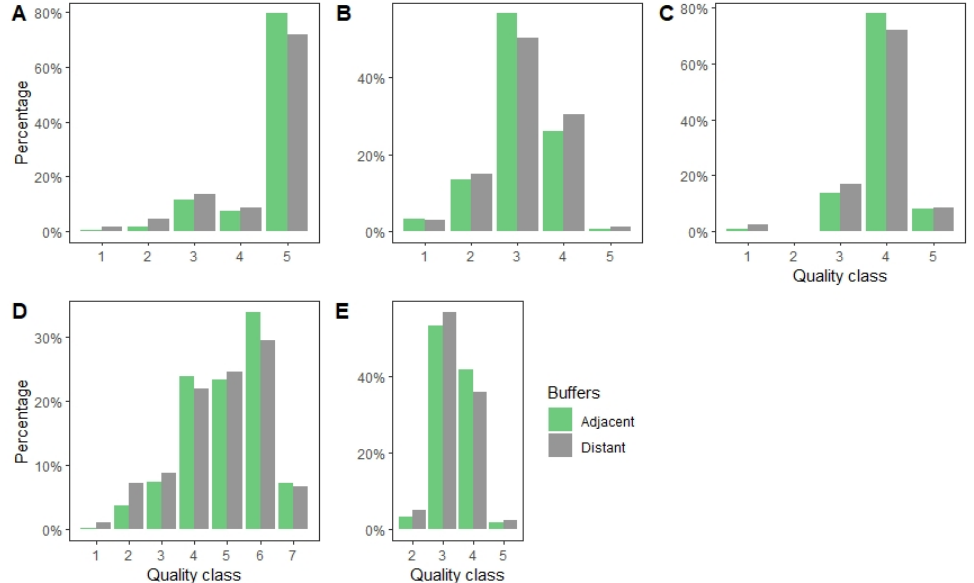
Figure 4. Percentage (%) of forest stands in adjacent (0–50 m) and distant (51–200 m) riparian buffers strips by indicator quality class. ( A ) is the indicator Potential for the presence of medicinal plants; ( B ) the indicator Flora with phytoremediation potential; ( C ) the indicator Potential for the presence of nectar plants; ( D ) the indicator Potential to withstand recreational pressure; and ( E ) the indicator Visual aesthetic quality of the forest landscape.